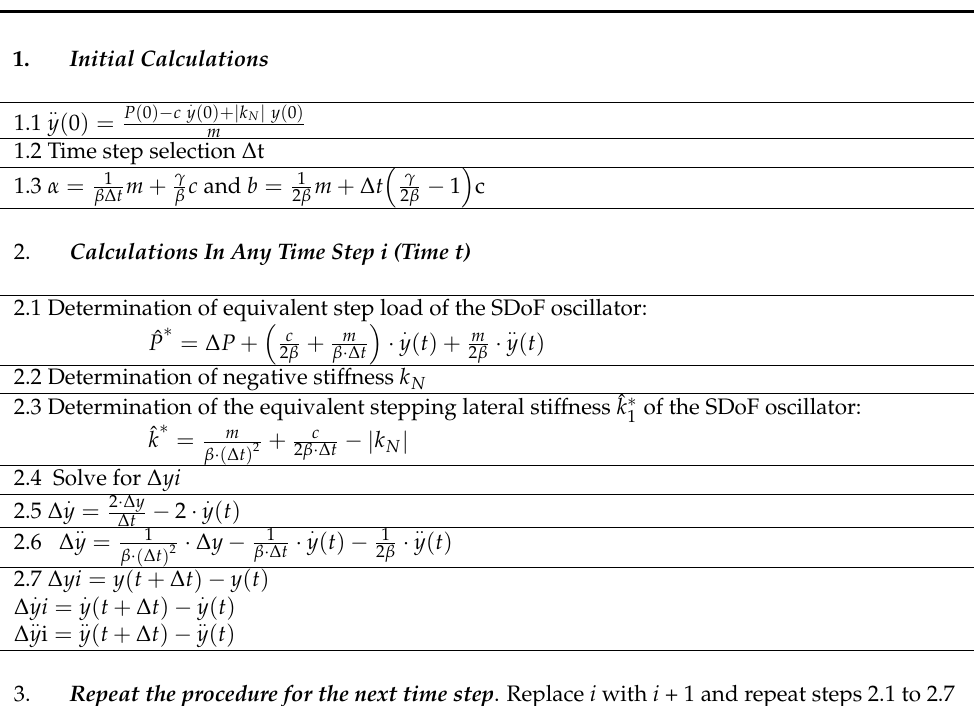
Table 1. Algorithm of the Newmark-modified method for a SDoF system with negative stiffness (linear acceleration method ( γ = 1/2, β =